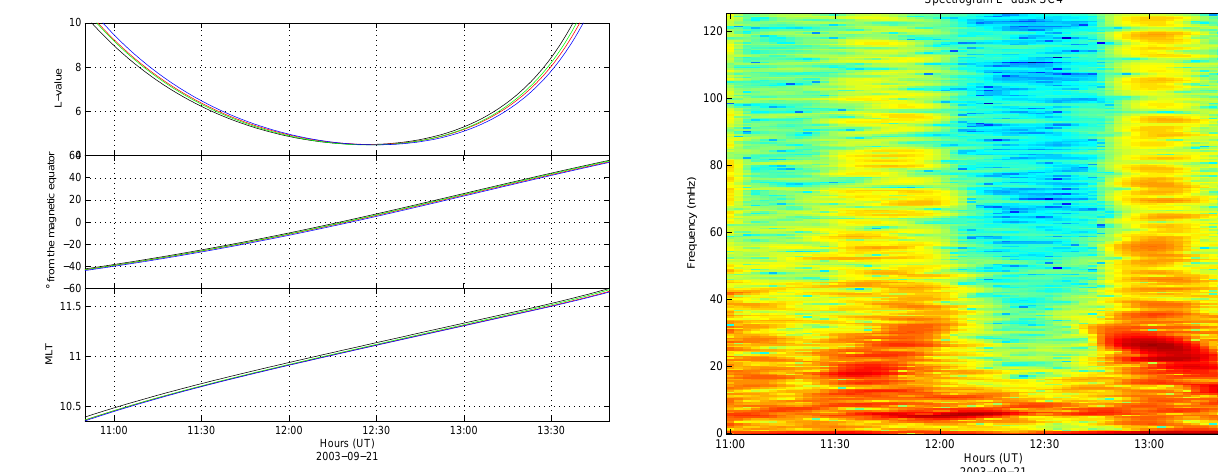
where ρ eq is the density at the equator, L is the McIlwain parameter, R E is the radius of the Earth, r the geocentric dis- tance to a point on the field line and α is the scaling